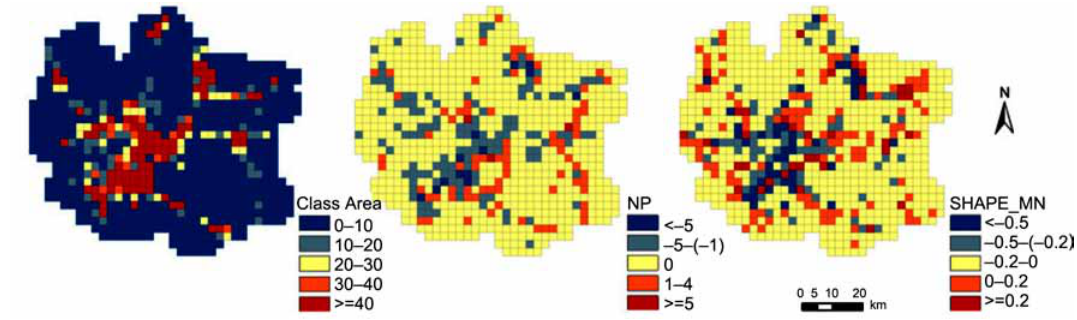
Fig. 13. Binary comparison between PSS scenario and observed landscape pattern 2010 in Class Area, NP, and SHAPE_MN values